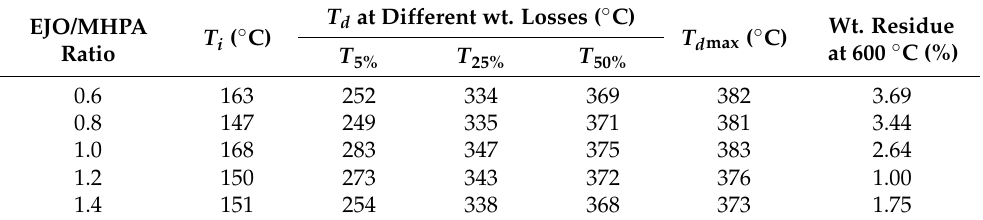
Figure 7. First-derivative weight curves (DTG) of EJO/MHPA polymers with various molar ratios of anhydride to oxirane. Table 1. Thermal properties of EJO/MHPA polymers from TGA and